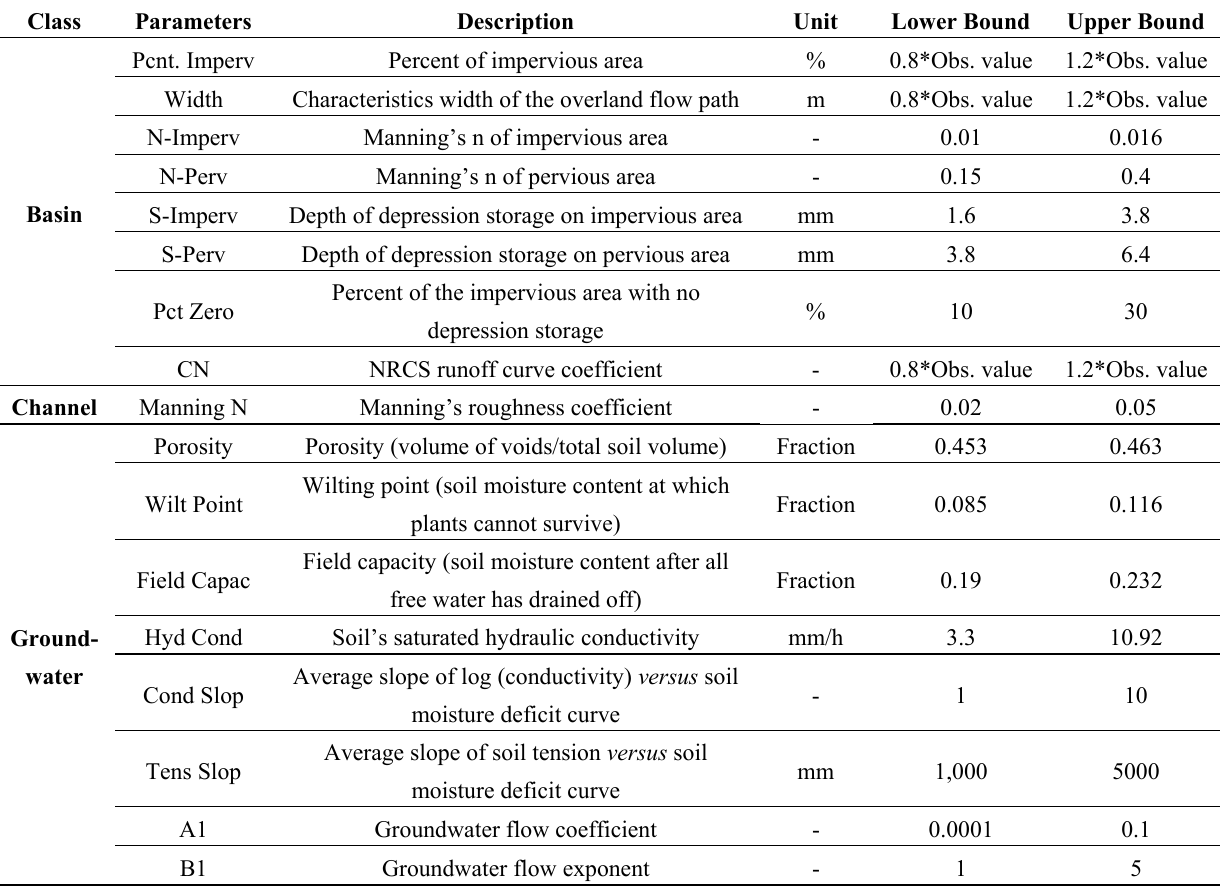
Table 2. Search boundary of parameters for the event simulation model for the study